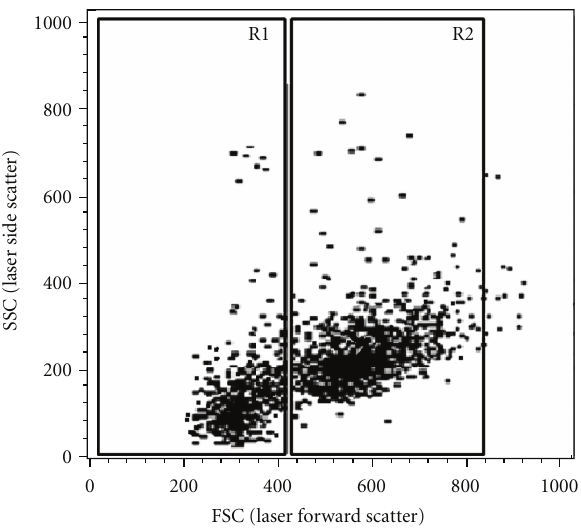
Figure 2: Profile of circulating haemocyte population in Biom- phalaria glabrata snails. Two haemocyte subpopulations (R1 = small—FSC between 200–400, R2 = large—FSC between 440–840 can be identified by flow cytometric dot plot distributions based on their laser forward scatter (FSC) versus laser side scatter properties